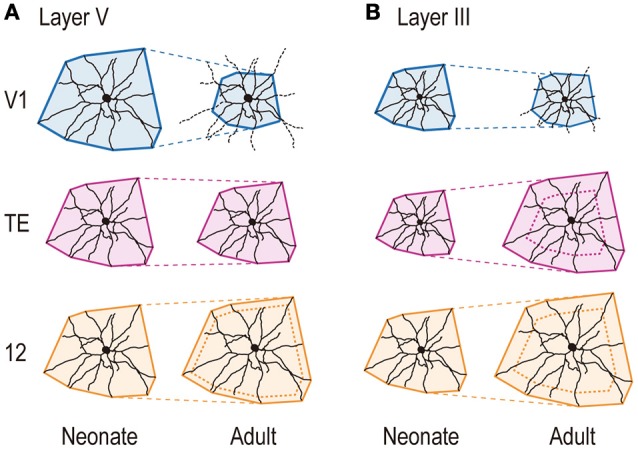
Schematic illustration showing area-specific and layer-specific developmental changes of pyramidal cell dendrites. The cells are drawn proportional in size to the mean dendritic field areas of corresponding area/age groups. Layer-V pyramidal cells in V1 retract basal dendritic arbors postnatally, whereas those in area TE remain constant in size, and those in area 12 become larger, increasing the size of their dendritic field areas (A). Layer-III basal dendritic field areas of pyramidal cells in area TE and area 12 increase with age, whereas those of V1 cells decrease (B). The scheme for layer V is based on the current results, and that for layer III is based on Elston et al. (2009, 2010a).